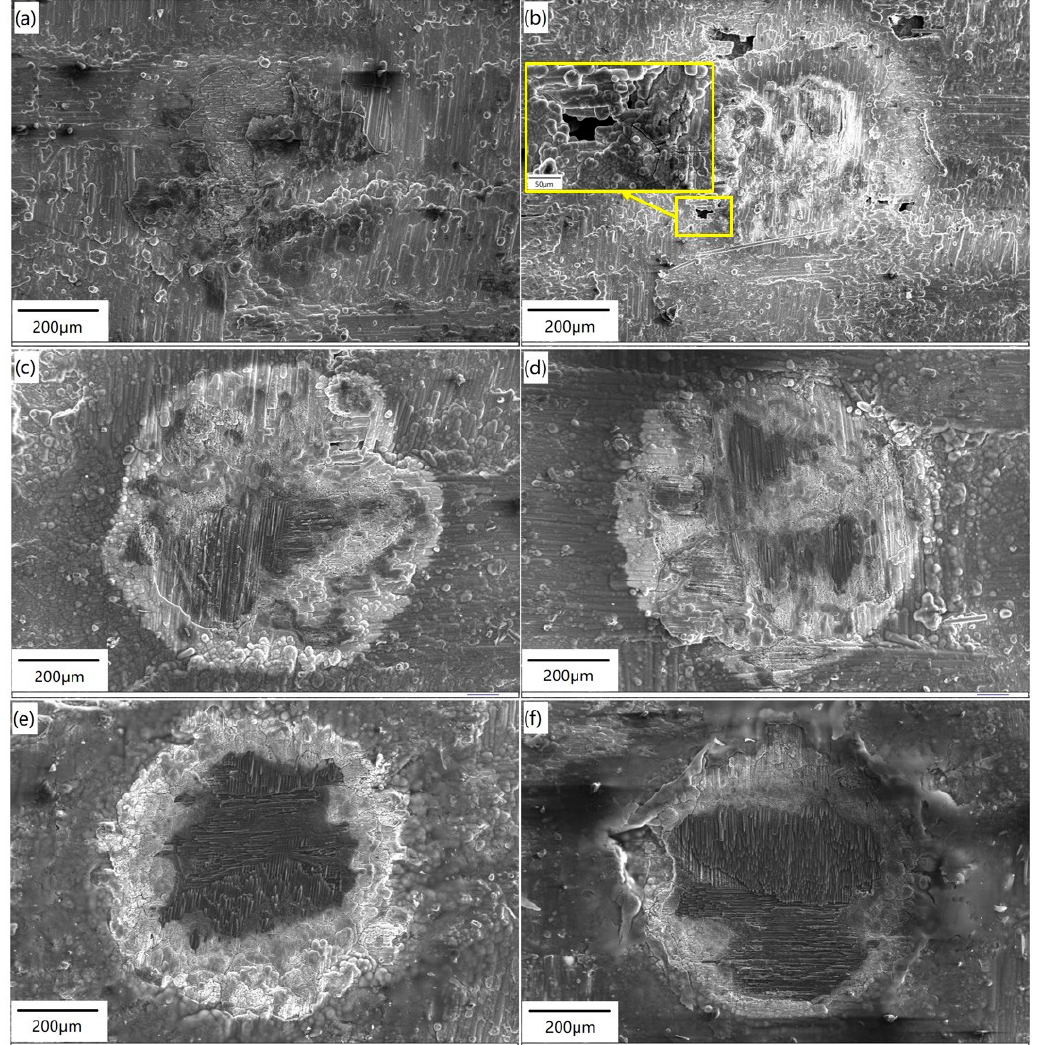
Figure 5. Surface morphology of the C/SiC composite irradiated under Condition A for different pulse numbers: ( a ) 1 pulse; ( b ) 2 pulses; ( c ) 5 pulses; ( d ) 10 pulses; ( e ) 50 pulses; ( f ) 100 pulses.